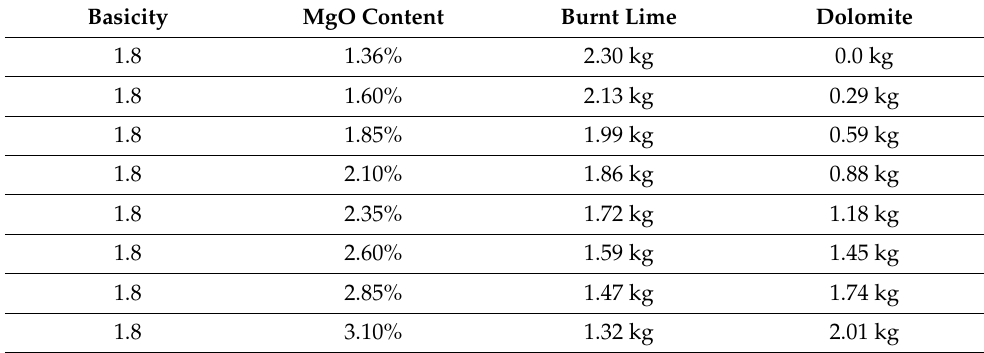
Table 2. The content of burnt lime and dolomite in each sintering blend.